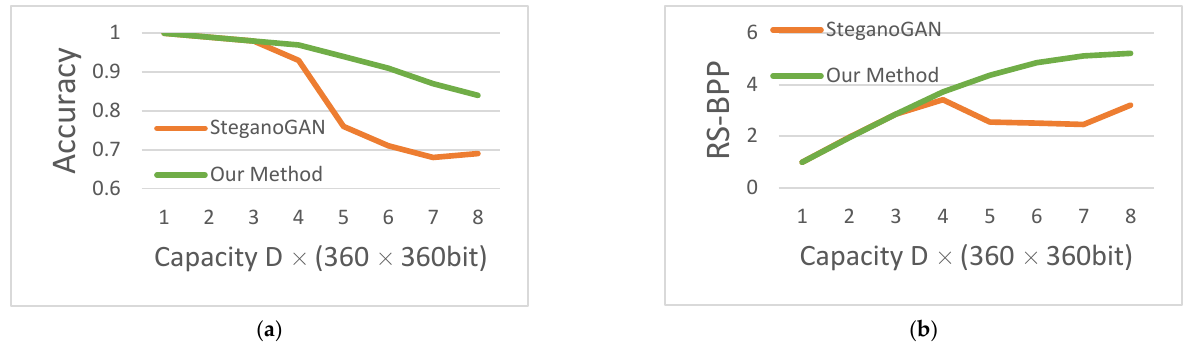
Figure 10. The accuracy and RS-BPP. ( a ) Decoding accuracy; ( b ) Reed-Solomon bits per pixel.